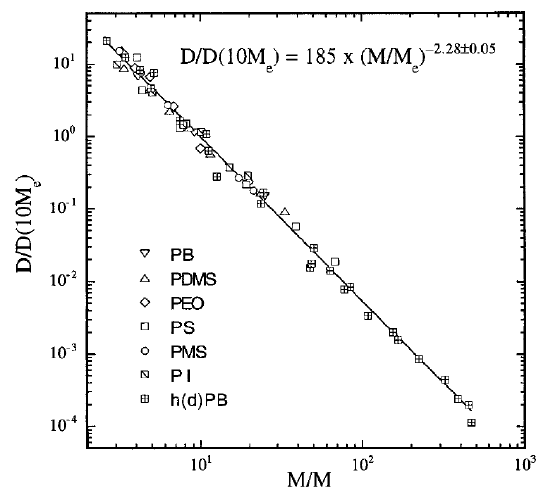
Figure 1. Melt self-diffusion data for hydrogenated (or deuterated) poly(butadiene) samples (hPB and dPB, respectively) adjusted to 175 °C, as a function of molecular weight and data for six other polymers from the literature, with the global power law fit [39,42,43,45,46,48–51]. Reprinted from [39] with permission from American Institute of Physics